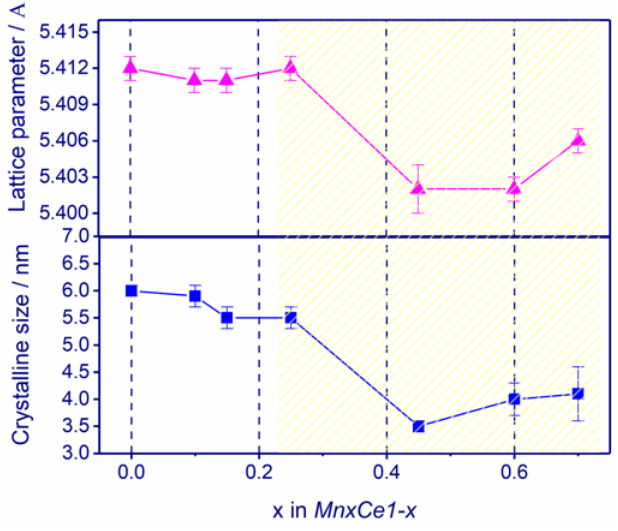
Figure 2. The lattice parameter and crystallite size and its dependence on the Mn content ( x ) in MnxCe1-x.